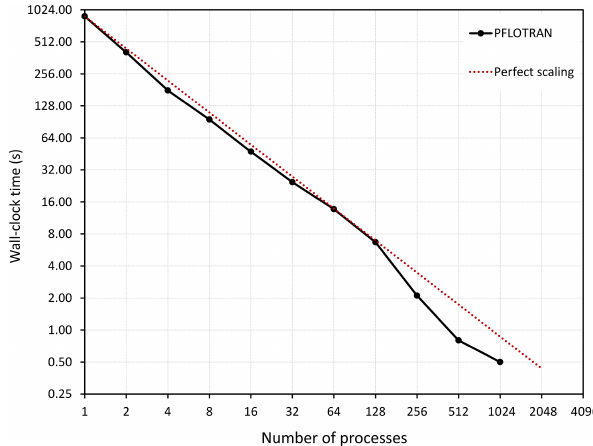
Figure 11. PFLOTRAN strong scaling for computing the Jacobian for the ERT inversion example in Fig. 7. The dimension of the Jaco- bian matrix J is 2070 × 864000 and is distributed uniformly over each computing process. PFLOTRAN exhibits superlinear perfor- mance for larger numbers of